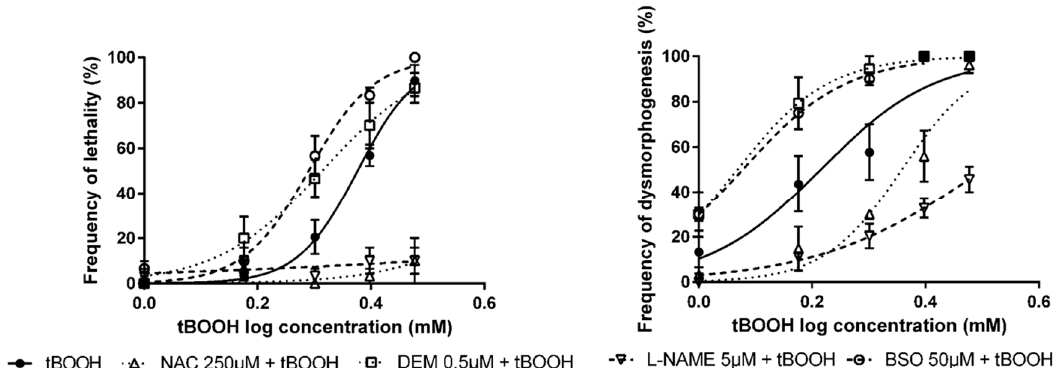
Figure 1. Concetration–response curves for lethality and dysmorphogenesis of tert-butyl hydroperoxide (tBOOH) alone or in combination with modulators of antioxidant status.